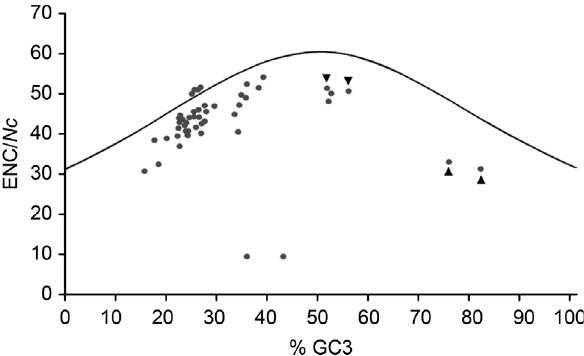
Figure 2 - Observed (dots) and expected (curve) effective number of codons ( Nc and ENC, respectively) on the Y axis and %GC3 on the X axis forBCoVandHCoV-OC43codingregions/mRNAsfornsps1-16,ns2and structural proteins HE, S, E, M, I and N and human and bovine CCK (left and right lower arrowheads, respectively) and SFTPA1 (right and left up- per arrowheads, respectively)